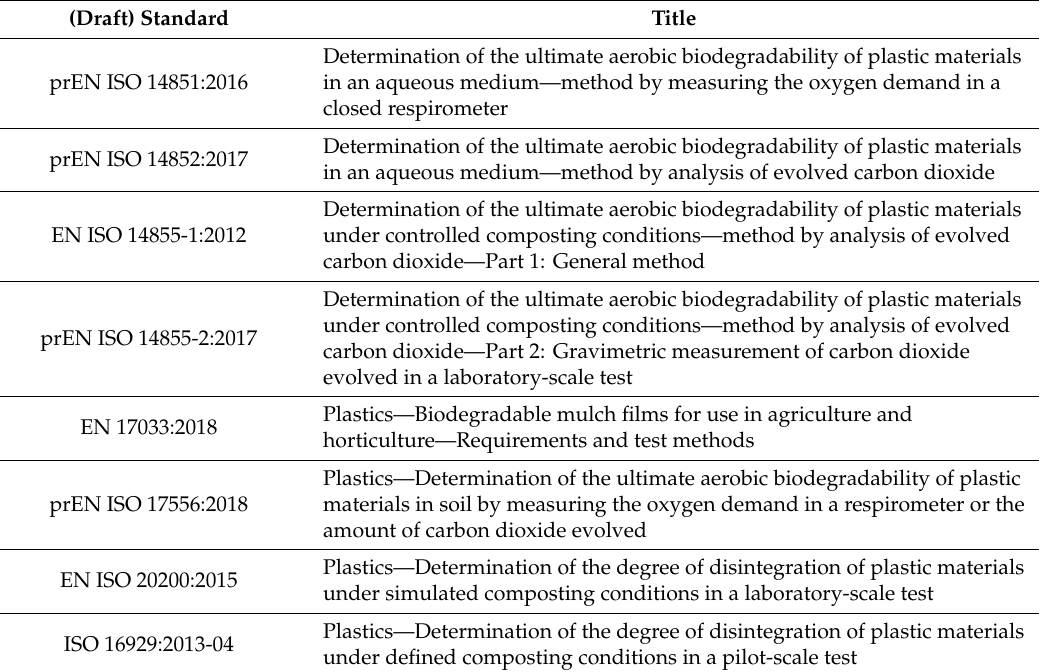
Table 4. Extract of latest standards and drafts in respect of biodegradability and